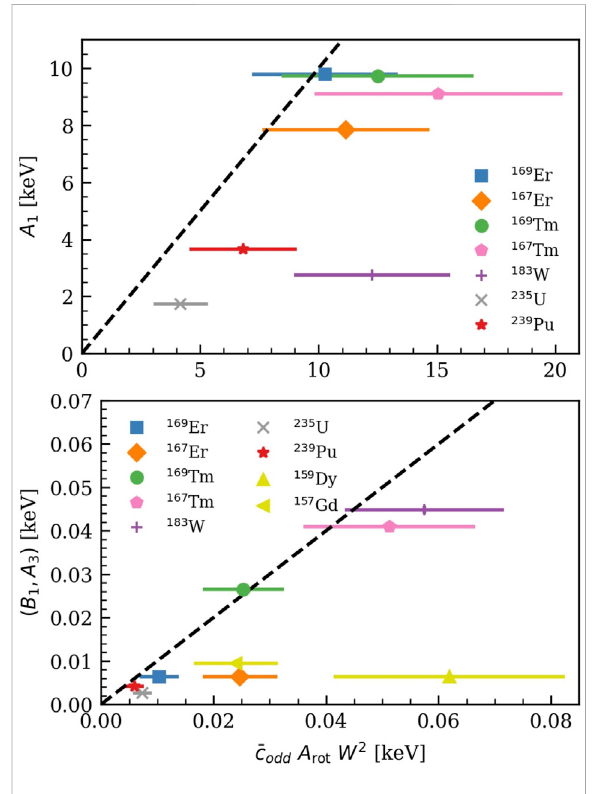
FIGURE 10 The size of the NLO LEC, A 1 (top panel) and the N 3 LO LEC, B 1 for K =1/2 bands and A 3 for K =3/2 bands (bottom panel), on the y -axis, compared to its expected size from the EFT power counting, on the x -axis. Error bands on the LEC distribution are small and can not been seen on the plot. The error bands on the x -axis encompass the 16th and 84th percentiles. Different nuclei are labeled in the legend of the plot. The black dashed line has slope =1 and is plotted to facilitate comparison of prior expectation and results from the posterior. The yellow colored symbols are results for rotational bands with bandheads K =3/2, all the others are K =1/2 bands. K =3/2 rotational bands do not have a parameter A 1 and we do not have them in the top panel. 99 Tc and 155 Gdareoutliersandweexcludethemfromtheplots(LECsvalues for these nuclei can be found in Table 1).